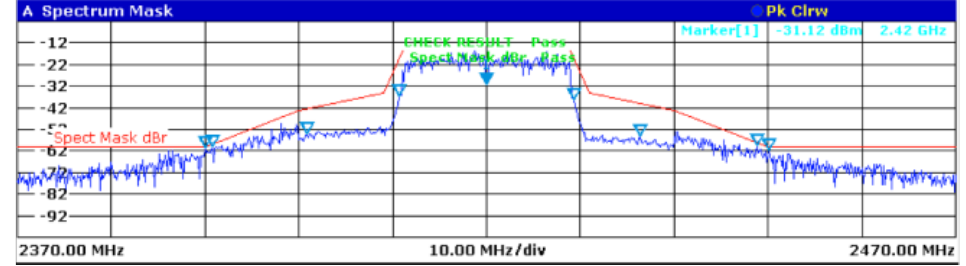
Figure 19. Measured results: spectrum mask at the output power of 21.5 dBm with 802.11 n signals with 20 MHz/64 quadrature amplitude modulation (QAM) at 2.42 GHz.